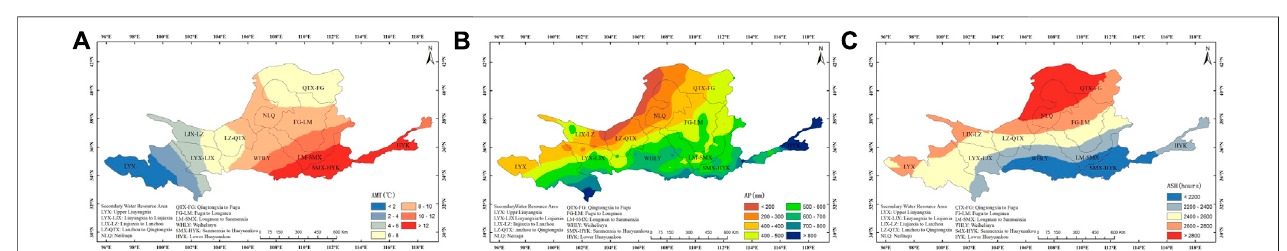
FIGURE 2 | Spatial distribution of average AMT (A) , AP (B) , and ASH (C) in the last 4 decades.